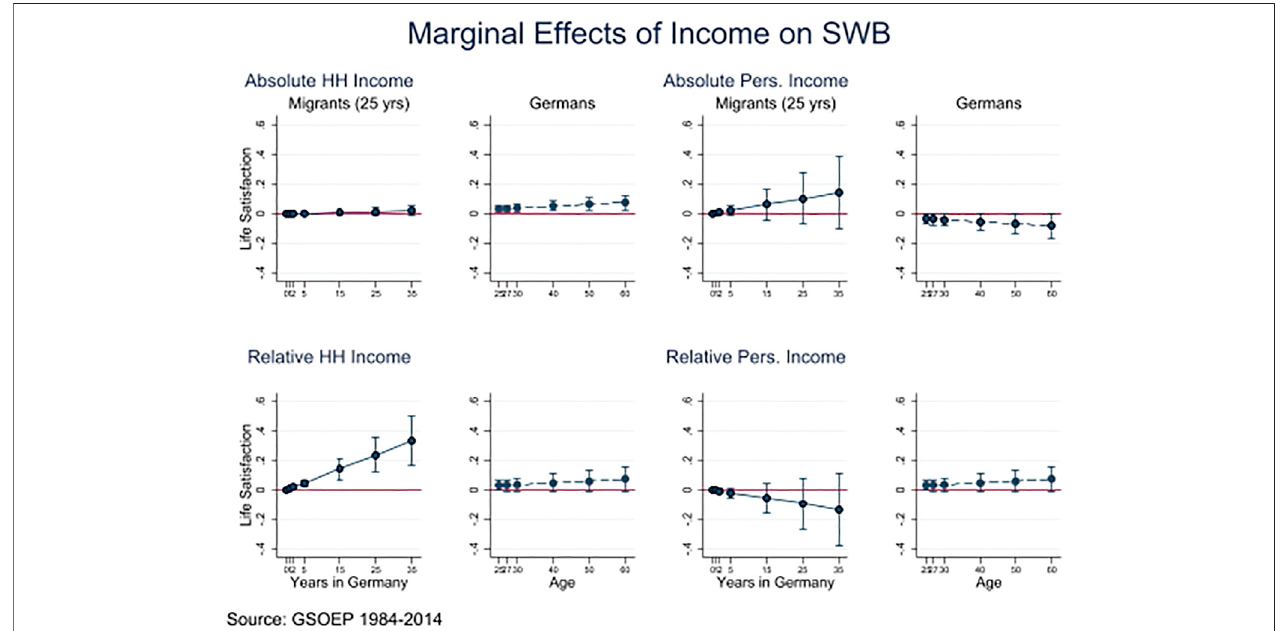
FIGURE 3 | Marginal effects of income on